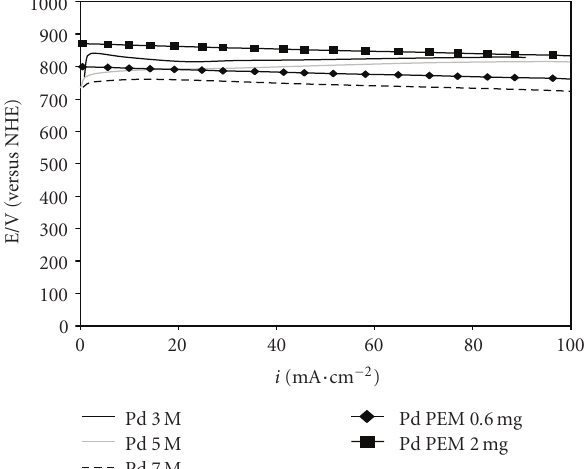
Figure 10: Cathode polarization curves for Pd MEA for a DMFC at 60 ◦ C fed with 3, 5, and 7M methanol solution compared to data from a H 2 PEM fuel